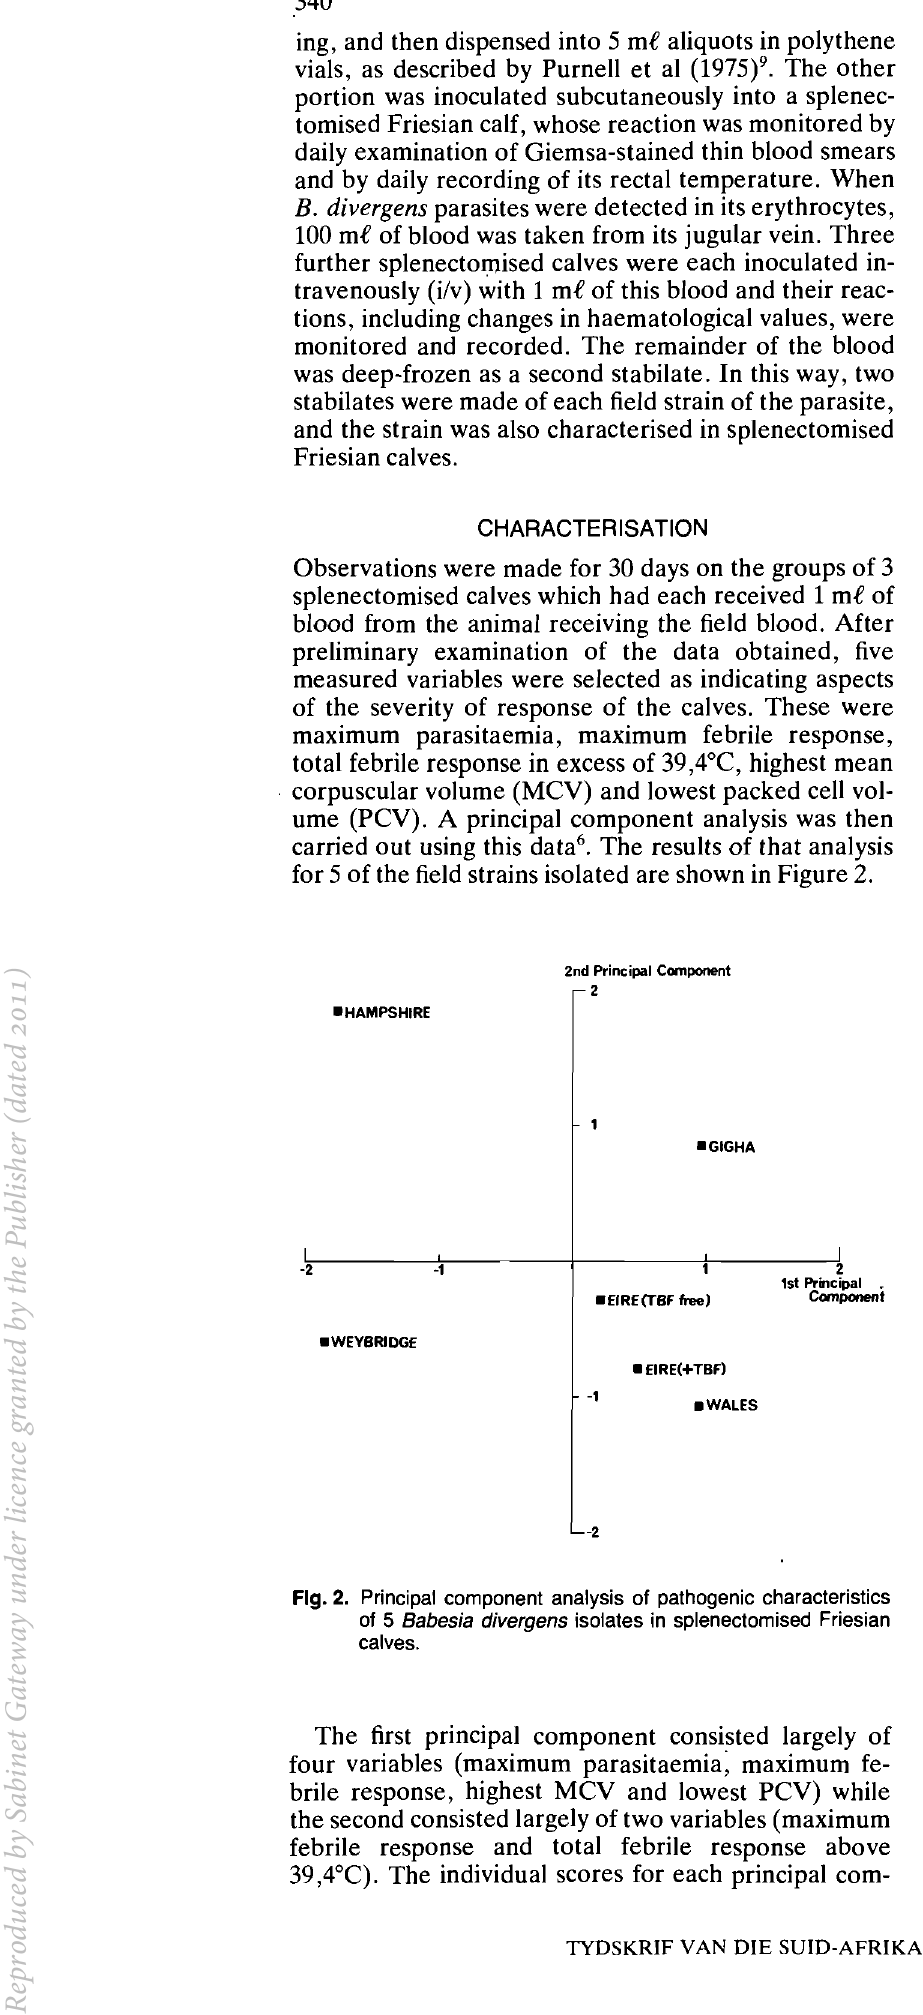
Fig. 2. Principal component analysis of pathogenic characteristics of 5 Babesia diver gens isolates in splenectomised Friesian